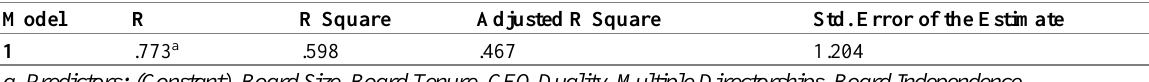
Table 6: Regression Model Summary